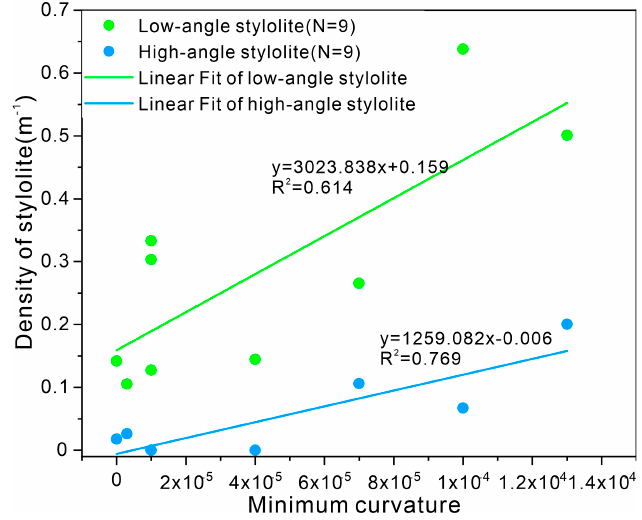
Figure 8. The relationship between minimum curvature and the density of stylolites.